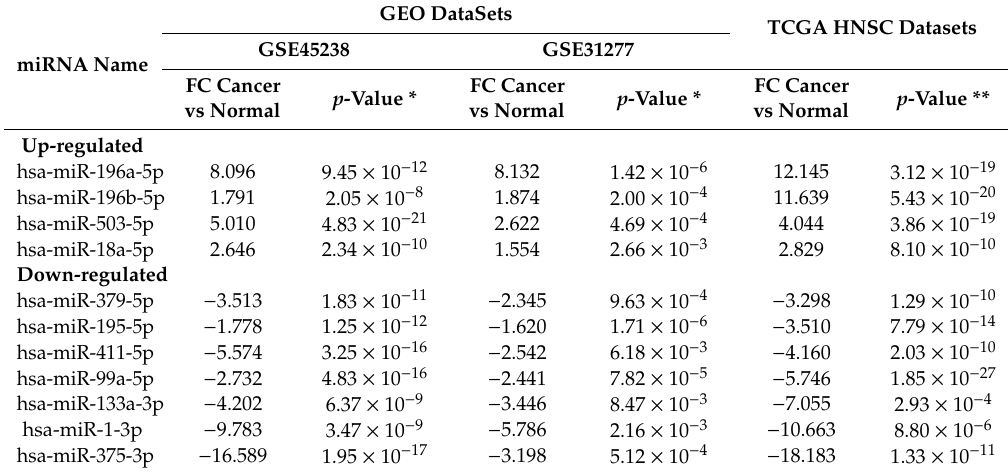
Table 3. Summary table of GEO DataSets and TCGA HNSC datasets “Cancer vs Normal” di ff erential